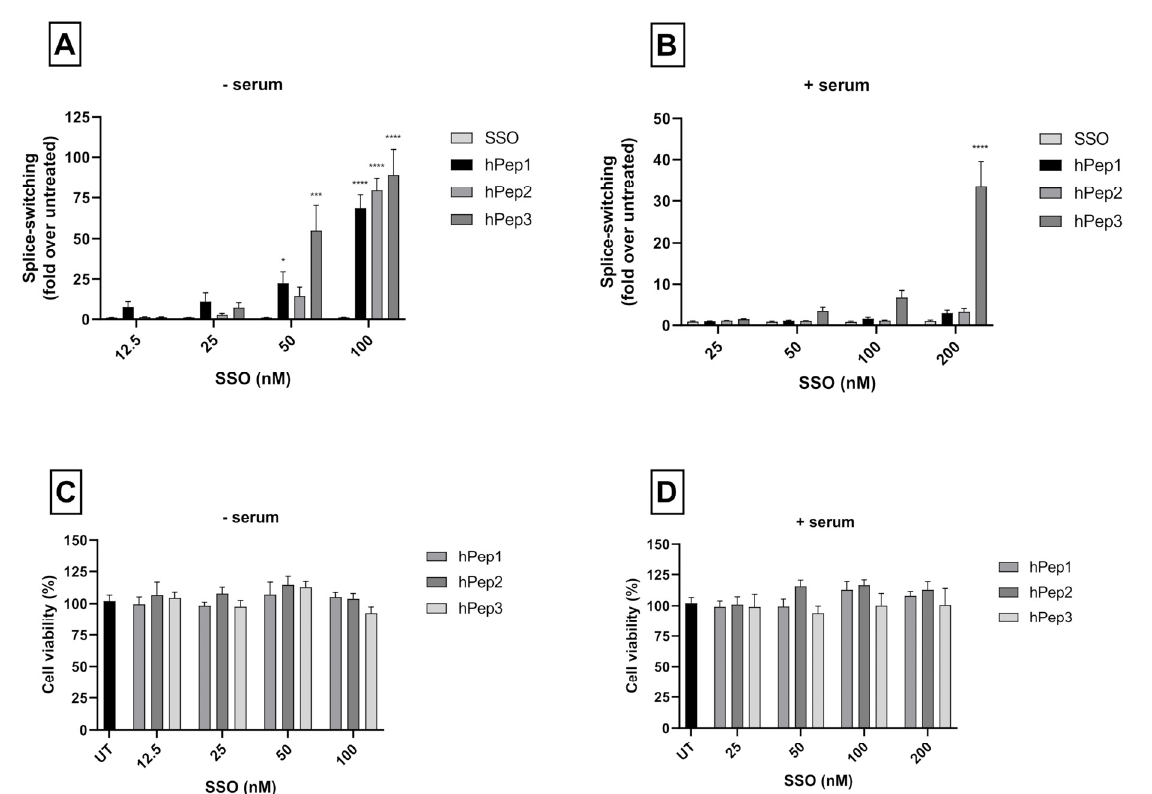
Figure 3. Dose-dependent splice-switching activity and toxicity evaluation of hPep/SSO nanoparticles in HeLa 705 reporter cell line. The efficacy of the complexes was examined via dose–response experiments in serum-free ( A ) and serum-containing transfection conditions ( B ). Splice-correction results are shown as fold-increase in luciferase activity over levels that were obtained from untreated cells. In a similar setup the cytotoxicity of the complexes was examined by WST-1 in serum-free ( C ) and serum-containing media ( D ). The cytotoxicity data are presented as percentage of untreated cells. The presented values are the mean of at least three independent experiments conducted in duplicates (mean ± SEM). p -values were determined by one-way ANOVA with Dunnett ′ s multiple comparison test (* p < 0.05, *** p < 0.001, **** p < 0.0001).